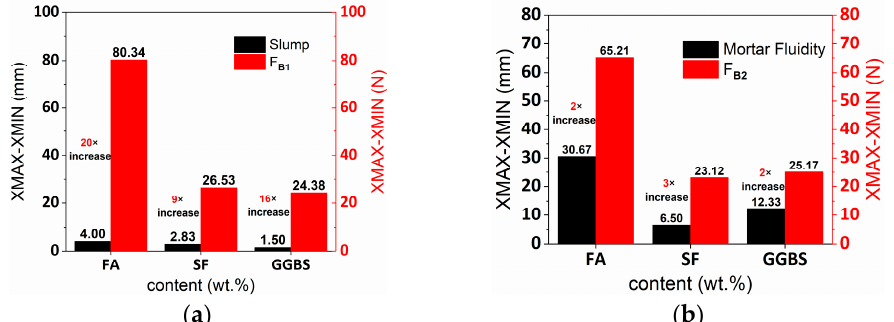
Figure 12. ( a ) F B1 and slump range value comparison, ( b ) F B2 and mortar fluidity range value com- parison.